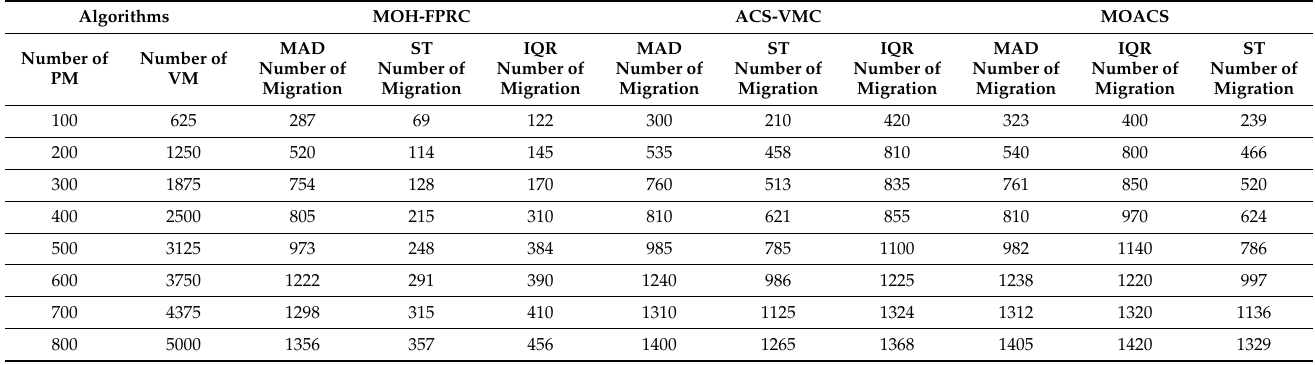
Table 5. Average energy consumption and SLA violation with different number of